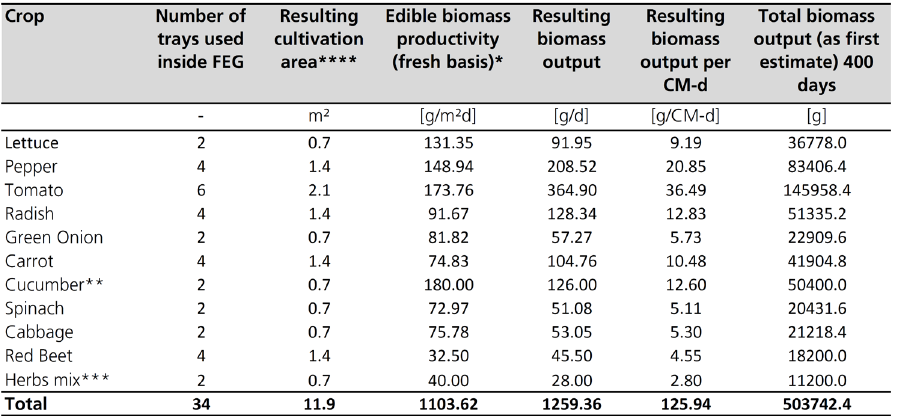
Table 2: Overview of adjusted crop list and tray allocation for the simulation according to EDEN ISS layout within the FEG. Values are based on the BAVD (Anderson et al. 2015) (with the exception of cucumber and herbs) and were adjusted to the FEG tray